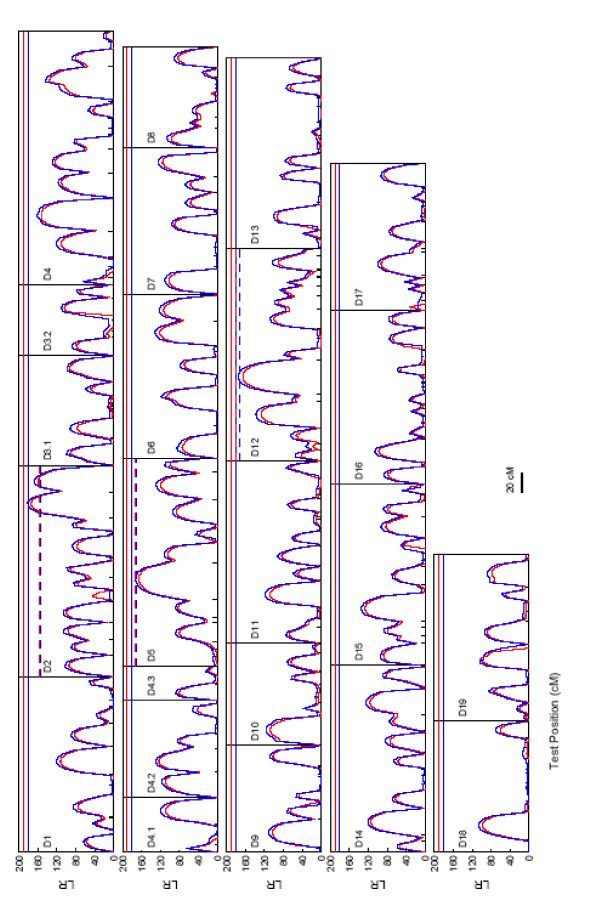
The profile of the log-likelihood ratios between the full (there is a QTL) and reduced (there is no QTL) model that combines stem volume index growth trajectories and flower timing across linkage groups in the Populus deltoides parent map. The genomic positions corresponding to the peaks of the curve are the MLEs of the QTL localization. The threshold values for claiming the existence of QTL are given as the horizonal solid lines for the genome-wide level and broken lines for the chromosome-wide level. Blue color corresponds to the unifying model for jointly mapping growth trajectories and flower trait, whereas red color corresponds to a model for mapping growth trajectories only. The positions of markers on the linkage groups (Yin et al. 2002) are indicated at ticks.